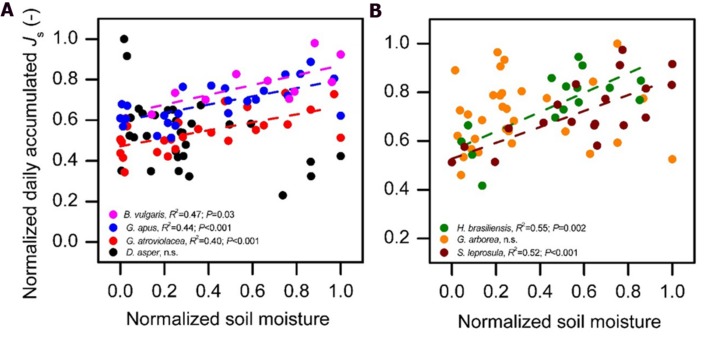
Normalized daily accumulated sap flux density (Js) of four bamboo species (A) and three tree species (B) in the ‘dry period’ (characterized with mean daily VPD > 0.74 kPa) plotted against normalized mean daily soil moisture content (SM). There was a significant linear relationship between Js and SM (P < 0.05) for all species except D. asper and G. arborea. Normalized values do not reach 1.0 for all species in the figure as the normalization was performed by setting the maximum value of the full measurement period of each species (including wet period) to one, while the figure displays only values in dry period. Daily averages derived from measurements on five culms per species, data of at least 10 dry period days per species.